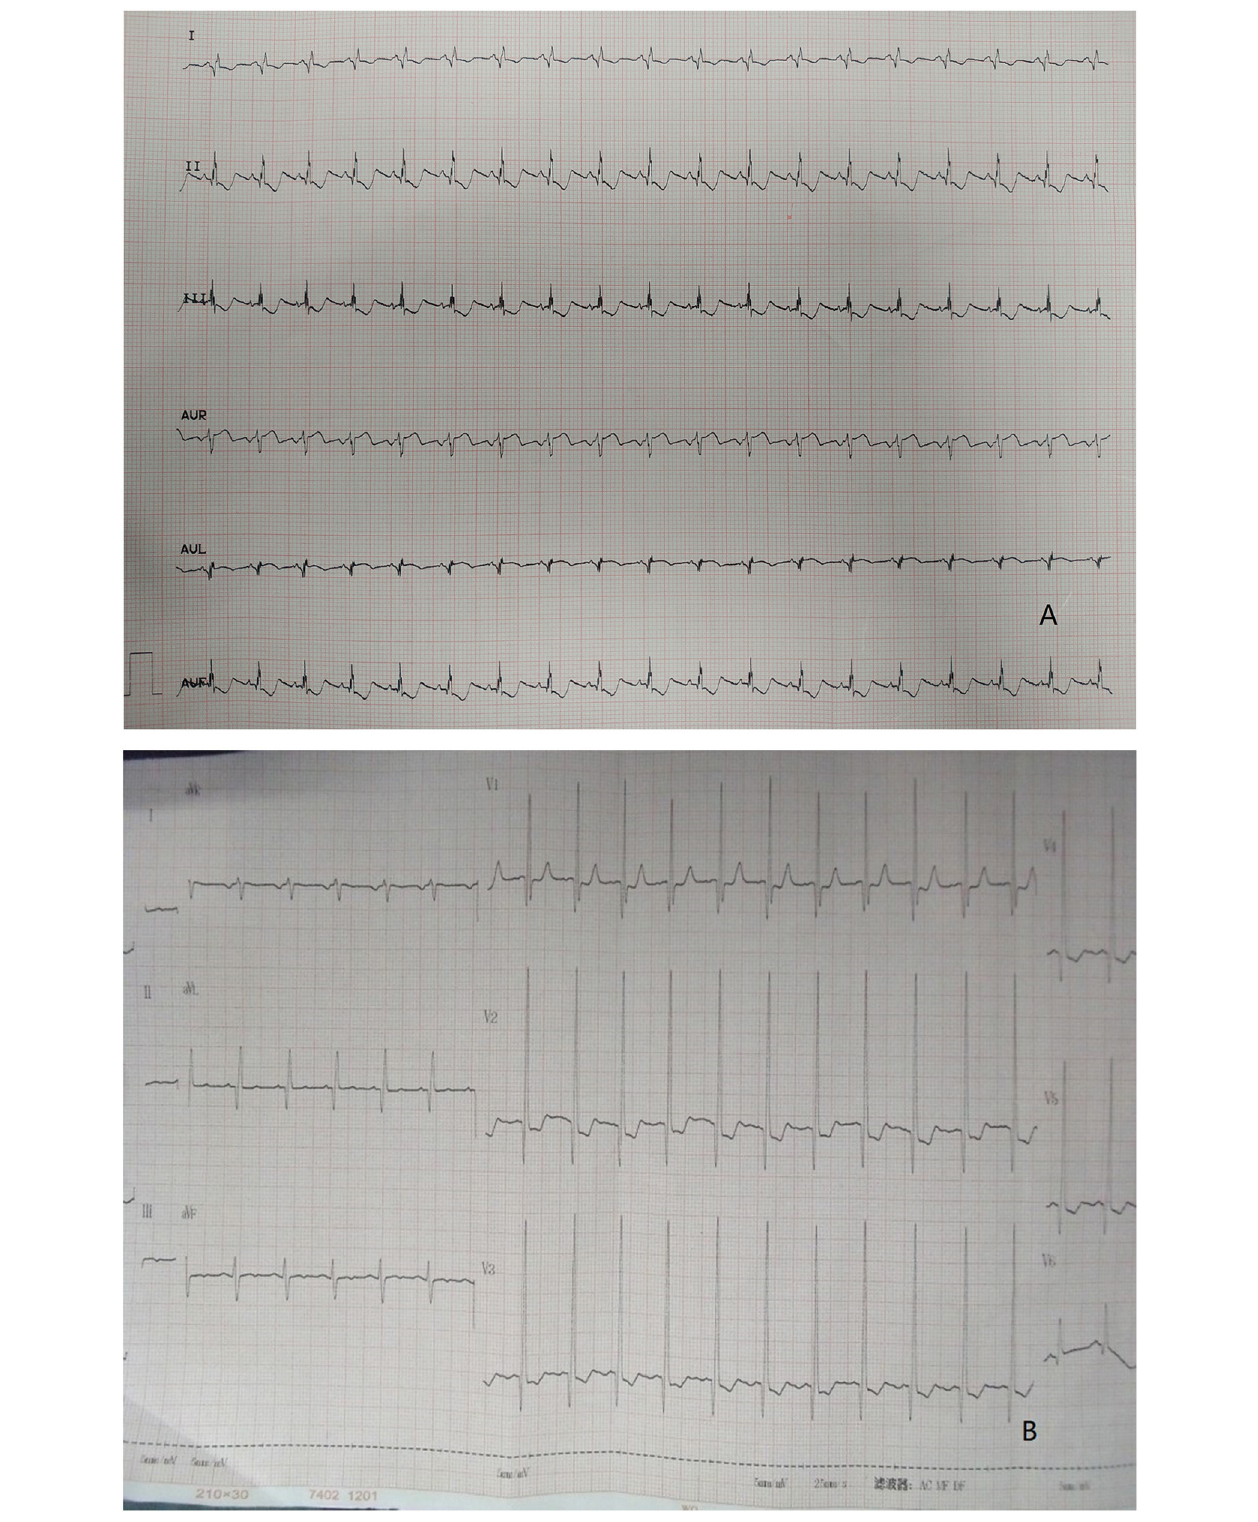
FIGURE 1 | (A) ECG: pathological Q waves in lead I, AVL. (B) ECG: pathological Q waves in lead AVL and ST segment depression in lead V2, V3.